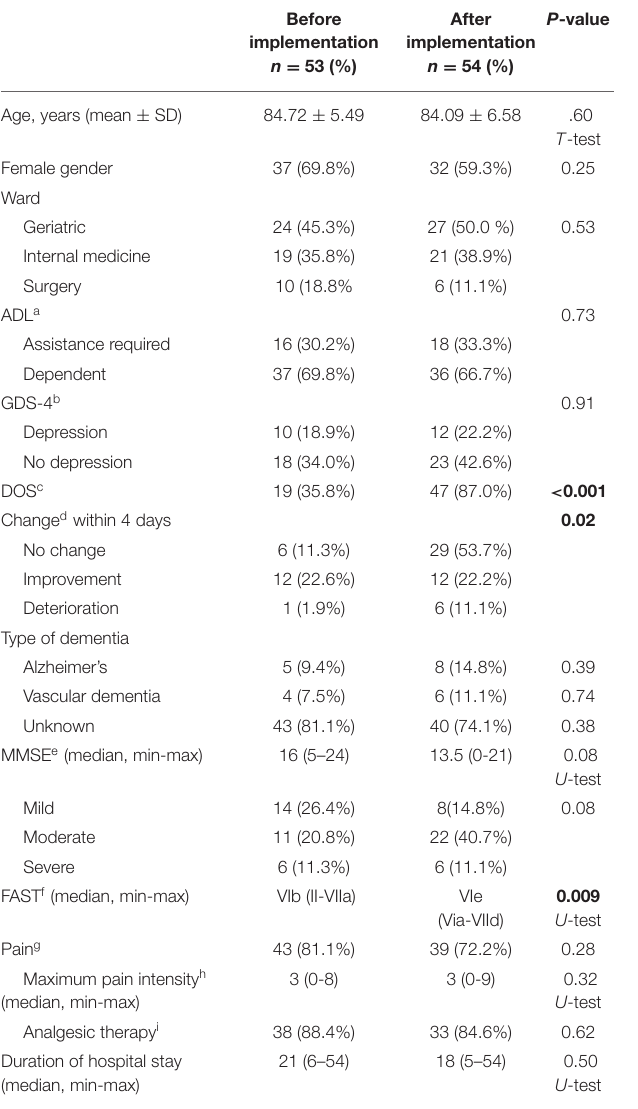
TABLE 2 | Severity of NPI-Q symptoms and changes within the study population on Days 1 and 4 before and after STI implementation, for NPI-Q-12 and